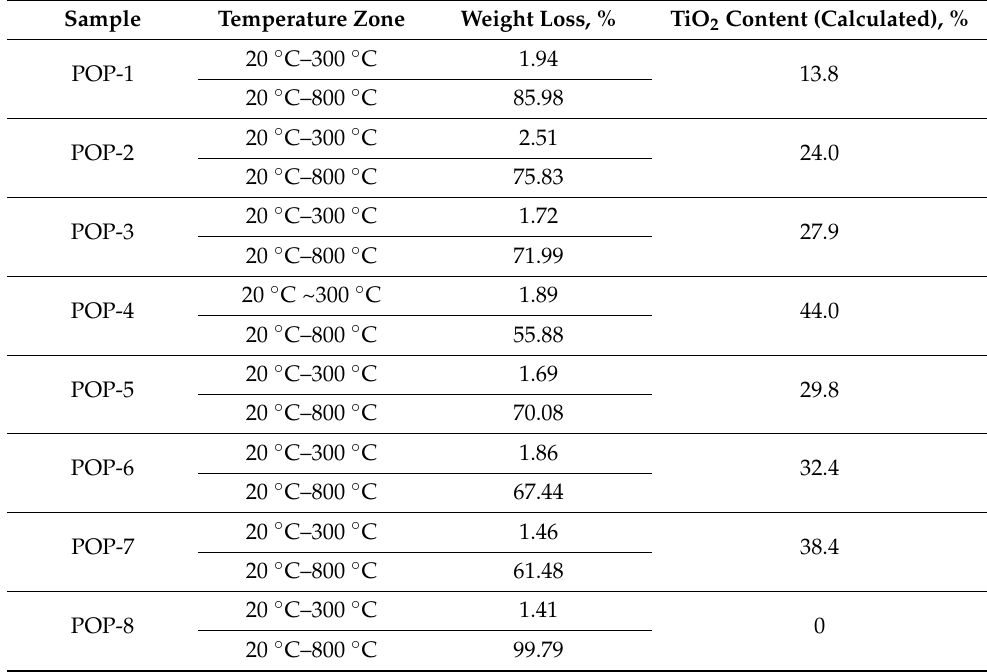
Table 2. The thermogravimetric analysis results of the prepared TiO 2 /POP